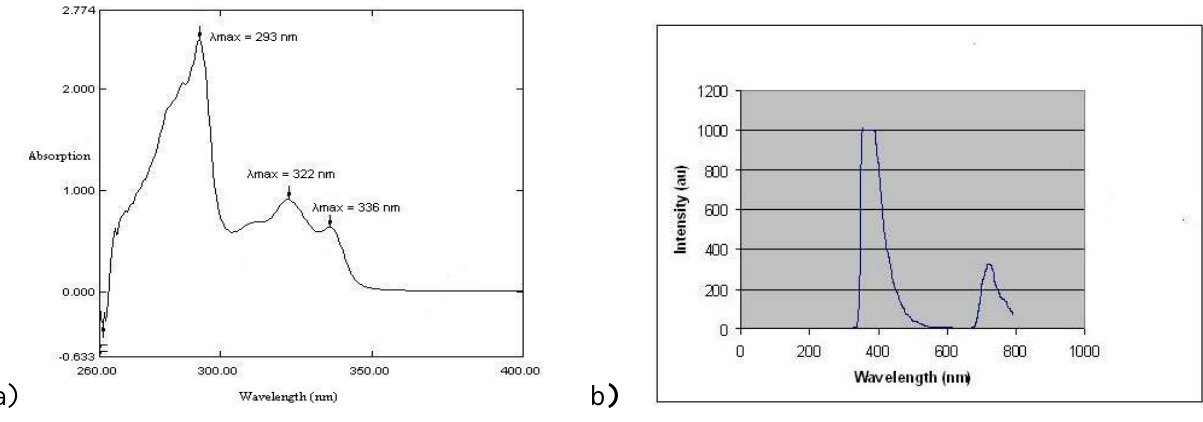
Figure 4. ( a ) The photoluminescence spectrum and ( b ) UV spectrum of compound ( 3 ) in dilute THF